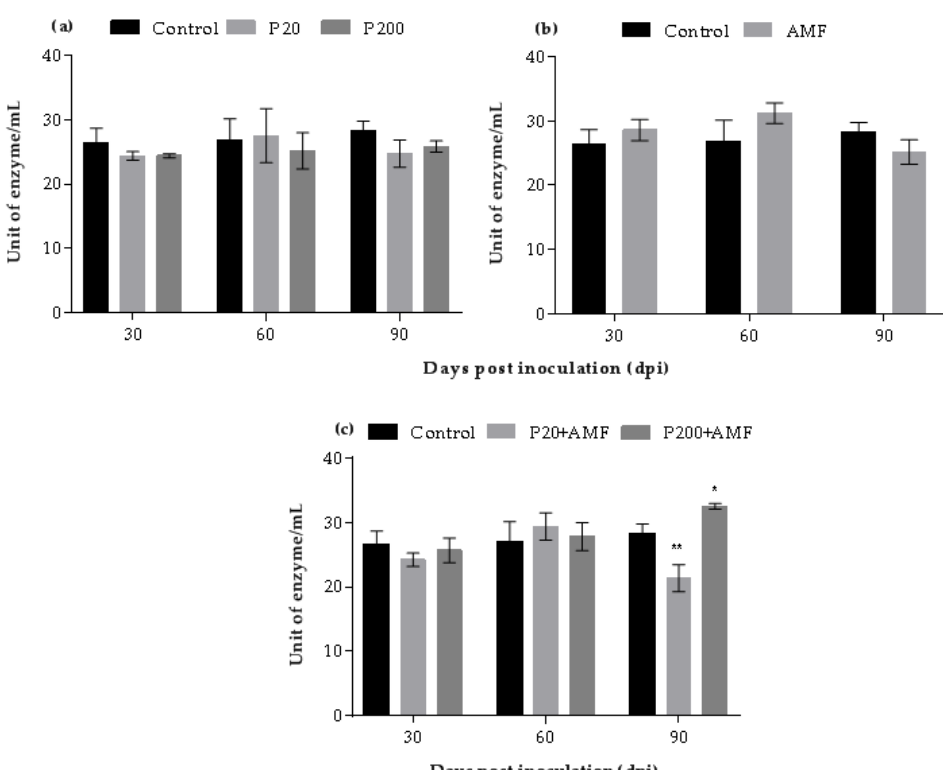
Figure 5. Phenylalanine ammonia-lyase enzyme activity in Piper divaricatum : ( a ) plants treated with 20 and 200 mg of P · dm − 3 of soil (P20 and P200); ( b ) plants inoculated with AMFs (AMF); ( c ) plants inoculated with AMFs and treated with 20 and 200 mg of P · dm − 3 of soil (P20 + AMF and P200 + AMF). Statistical difference according to Bonferroni test ( p < 0.05). Significance level: ** significant ( p < 0.01), * low significance ( p < 0.1) .